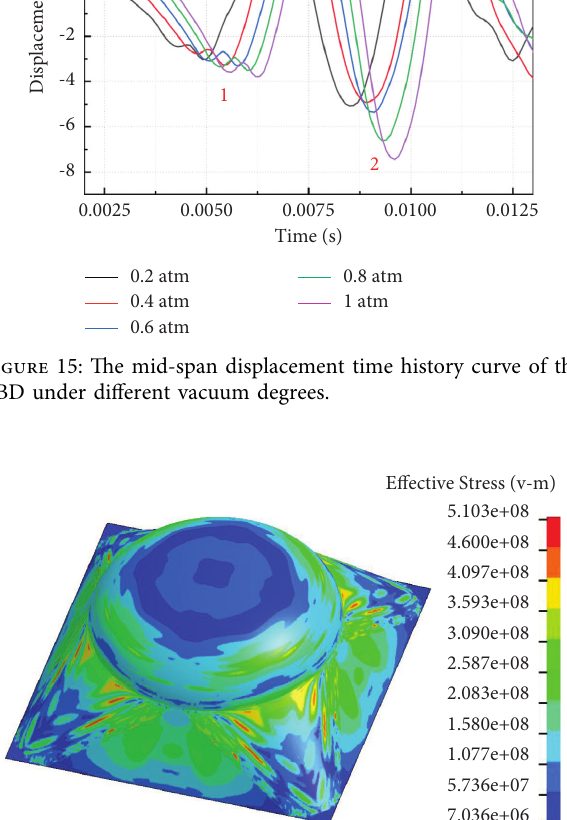
Figure 18: Explosive load under different explosive